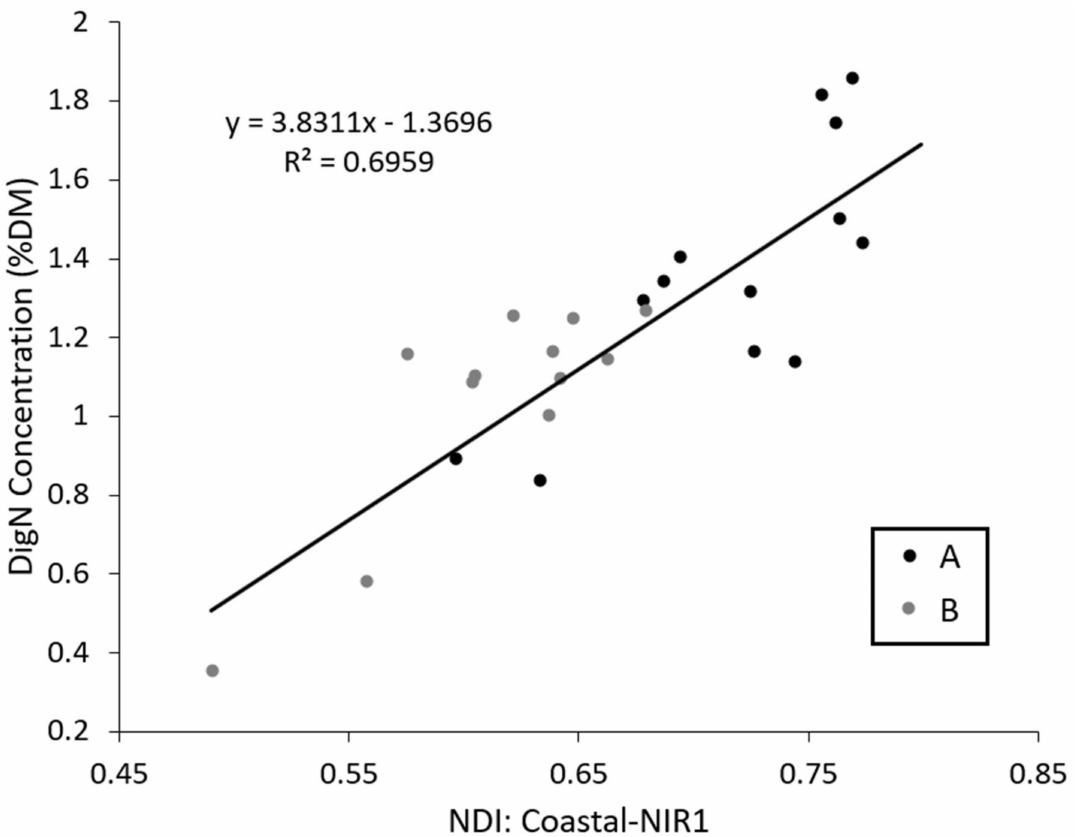
Figure 5. Regression of the relationship between digestible nitrogen (DigN; % dry matter) and NDI of MUL1 (Coastal) and MUL7 (NIR1) bands. NDIs were calculated from WorldView-3 images of Landscape A and B at 7.5 m spatial